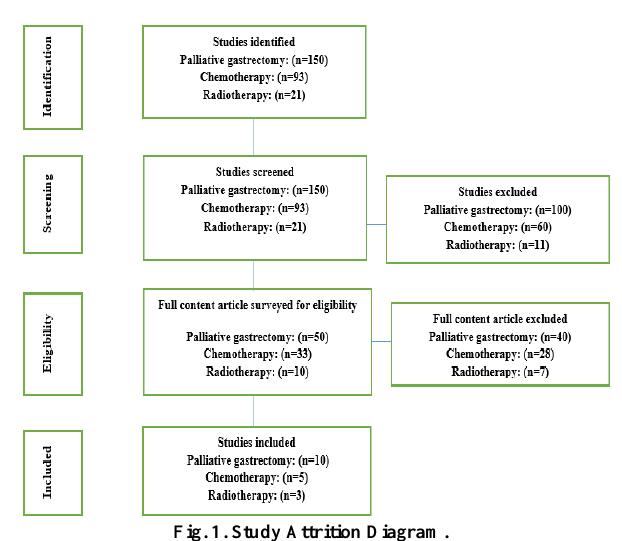
Fig. 1. Study Attrition